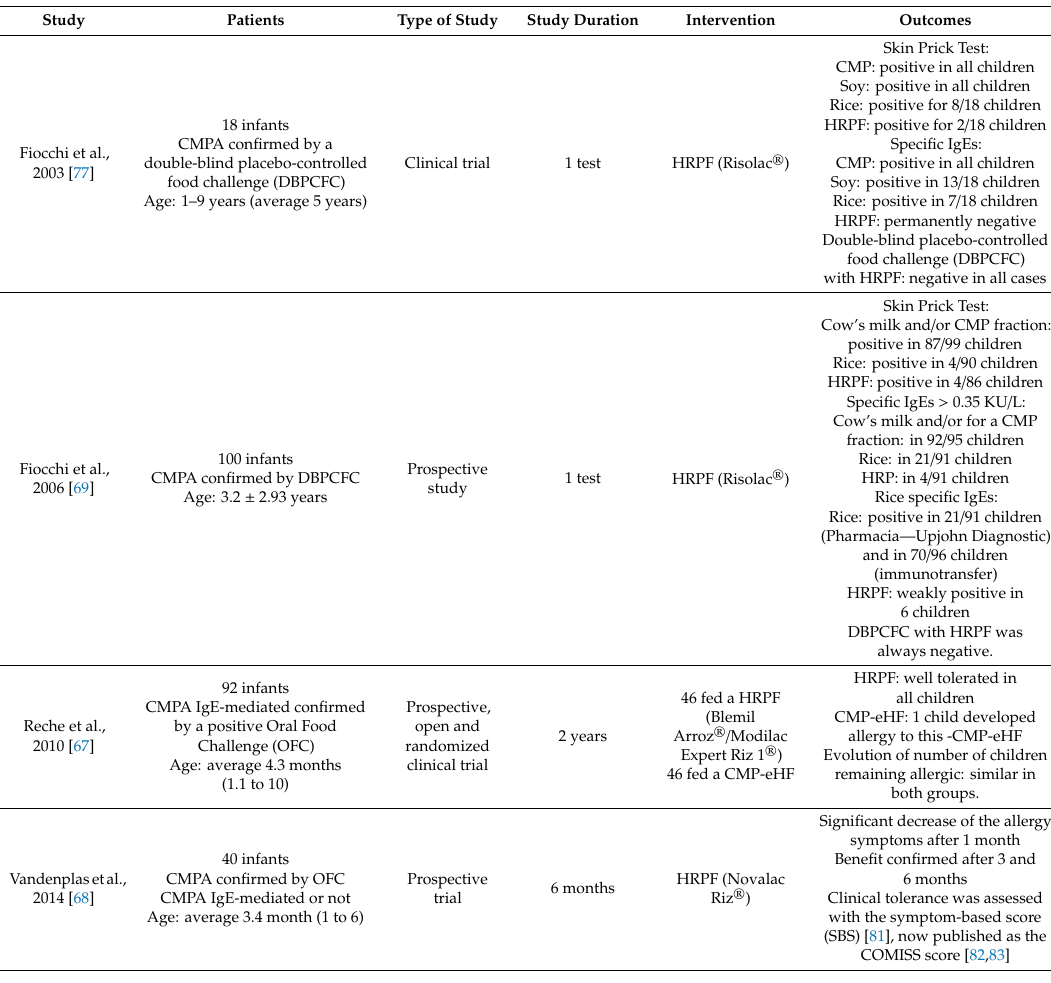
Table 5. Allergenic e ffi ciency of HRP formulas in CMPA